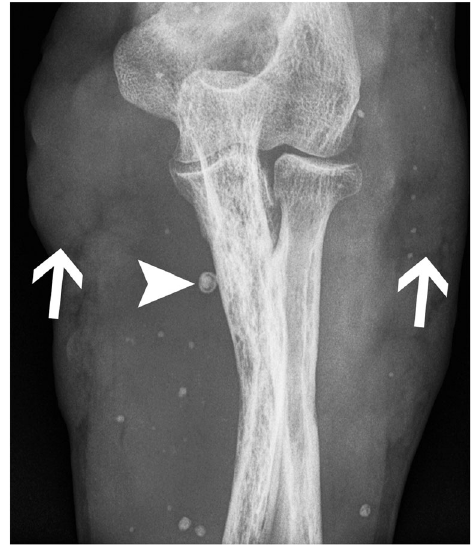
Fig. 22 Phleboliths. Anteroposterior radiograph of the elbow shows phleboliths in the soft tissues with the characteristic central lucency (arrowhead) in a patient with a venous malformation of the upper extremity. Note multifocal soft tissue masse effect that corresponds to the diffuse venous malformation